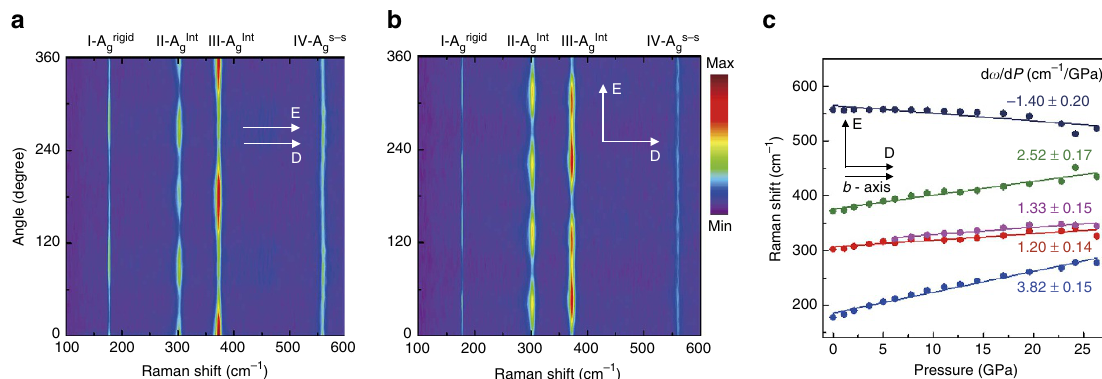
Figure 4 | Polarization dependence of Raman modes and their pressure dependence. Angle-resolved Raman spectroscopy (2D contour plots) for all the Raman peaks in the ( a ) normal (E || D) and ( b ) orthogonal (E > D) configuration. E and D represents the excitation direction and detection direction, respectively. ( c ) Evolution of Raman spectrum in orthogonal configuration displaying similar pressure-dependent trends and d o / d P values.